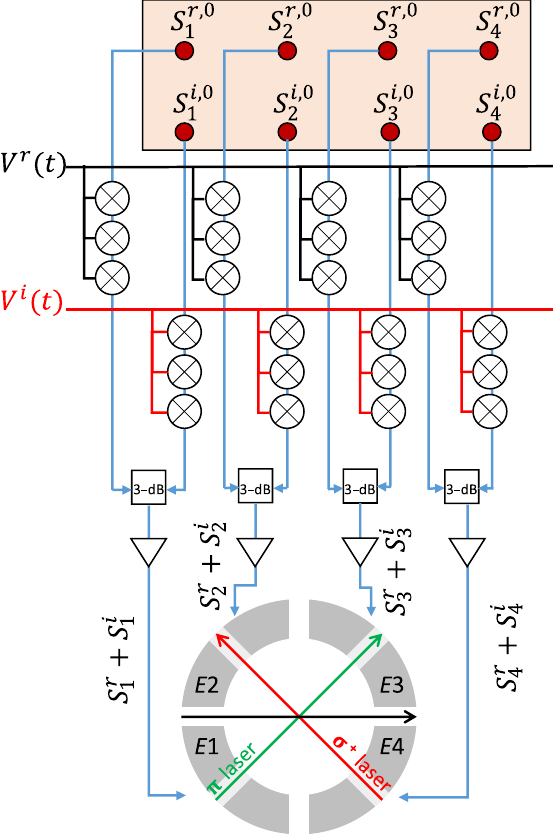
FIG. 11. Radio-frequency circuit. The outputs of an eight- channel synthesizer (light red), labeled S r; 0 1 , S r; 0 2 , S r; 0 3 , S r; 0 4 , S i; 0 1 , S i; 0 S i; 0 S i; 0 2 , 3 , and 4 , are sent to eight sets of three successive mixers that are controlled either by the voltage V r ð t Þ (black line, for the outputs S r; 0 1 , S r; 0 2 , S r; 0 3 , S r; 0 4 ) or by V i ð t Þ (red line, for the outputs S i; 0 S i; 0 S i; 0 S i; 0 1 , 2 , 3 , 4 ). The resulting signals are combined two by two using 3-dB couplers and sent to amplifiers, which feed the four ring electrodes surrounding the experiment (in